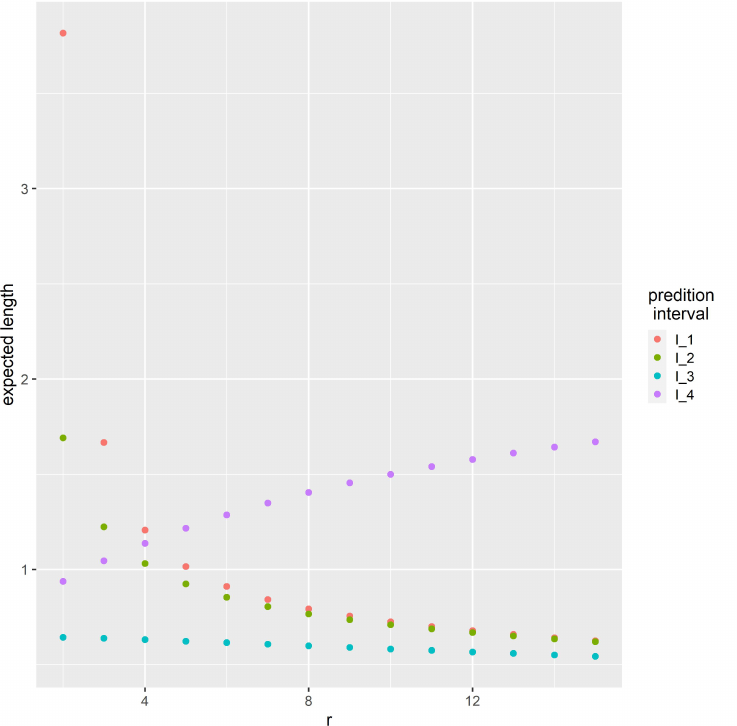
Figure 2. Expected lengths of the 90% prediction intervals I 1 , . . . , I 4 for the next but one lower record value ( s = r + 2) based on the first r lower record values from a Pow ( λ , β ) distribution with λ = 11.3 and β =